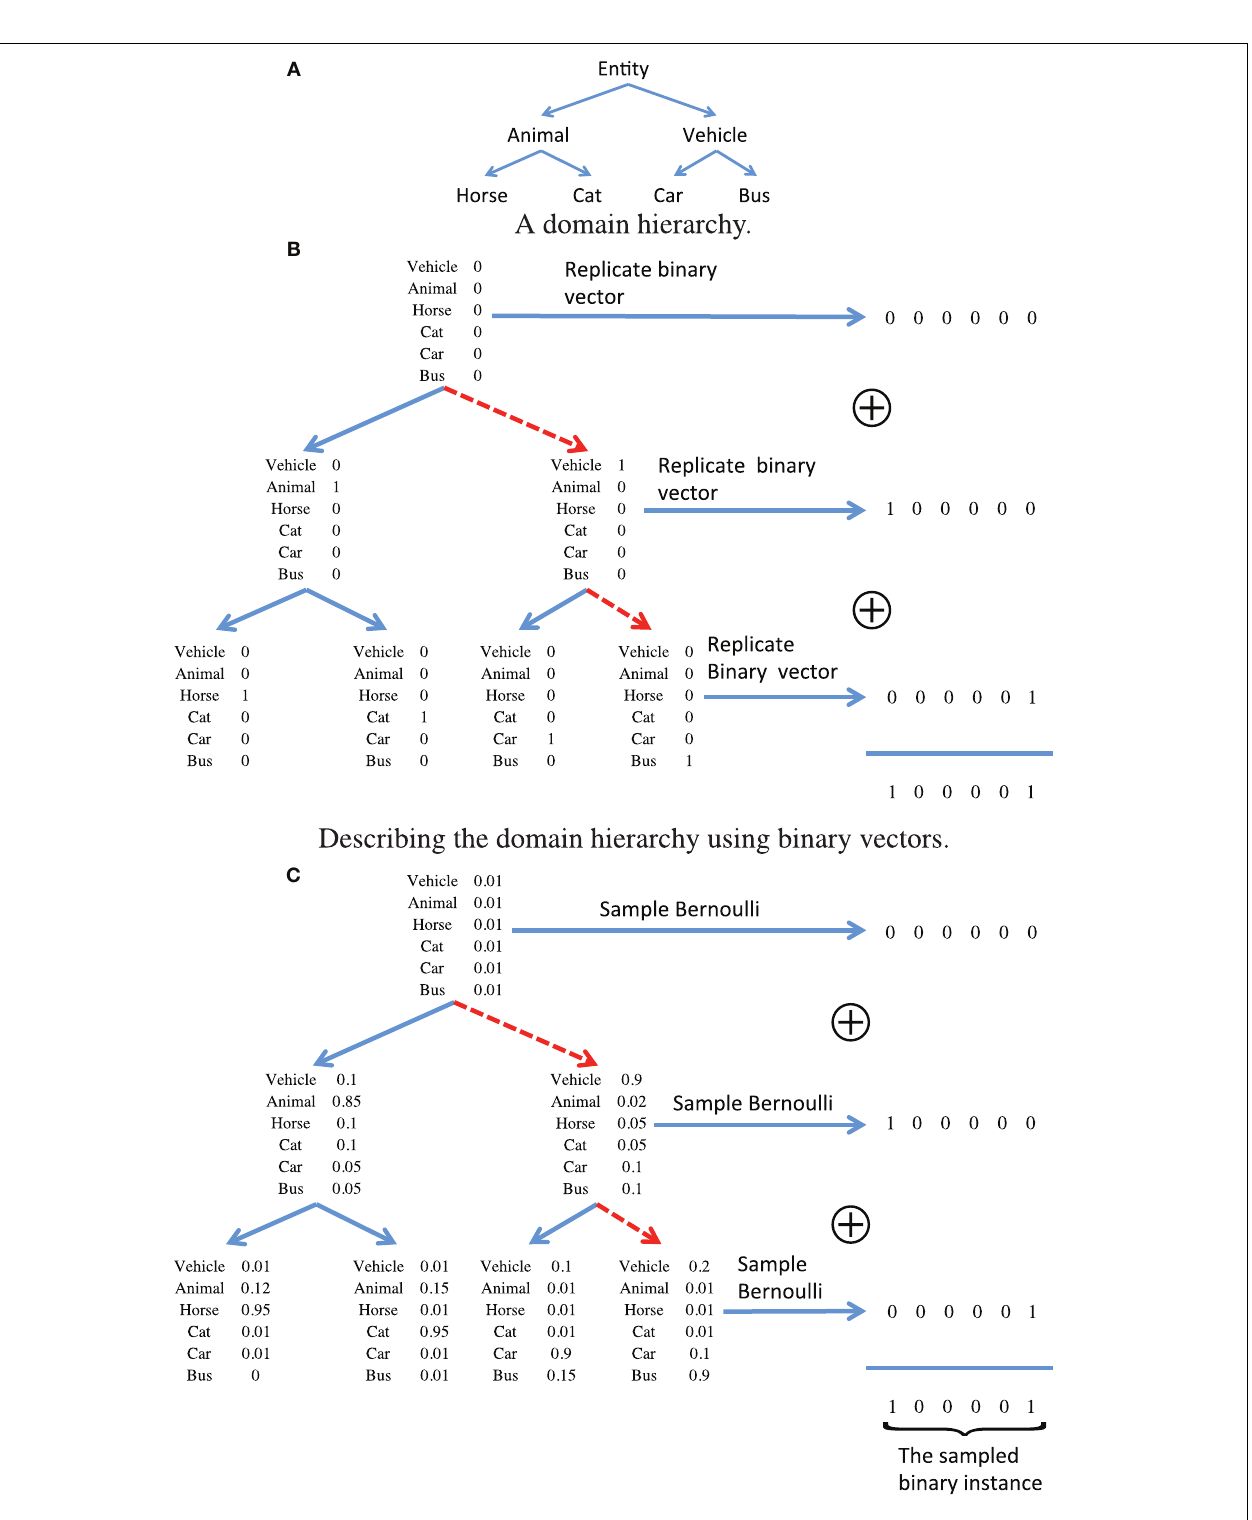
Frontiers in Psychology | Perception Science May 2014 | Volume 5 | Article 417 |